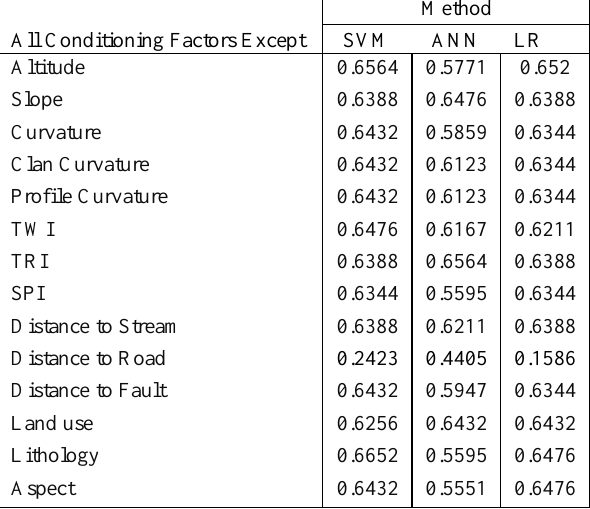
Table 5. Cohen's Kappa Index for SVM, ANN, and LR techniques of landslide susceptibility by removing one conditioning factor in a time.